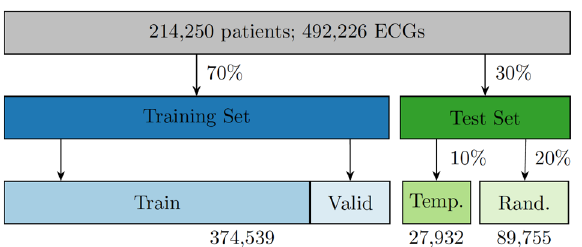
Figure 6. Data splitting of the study sample. The dataset was split in a training set consisting of 70% and two test sets consisting of 10% and 20% of the complete data each. The last row in the figure lists the total number of ECGs in each data split. Repeated ECG recordings at the same visit of a patient were added to the training set